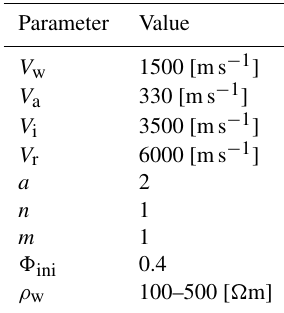
Table 2. Overview of the values attributed to the free parameters in the three equations of the 4PM in this